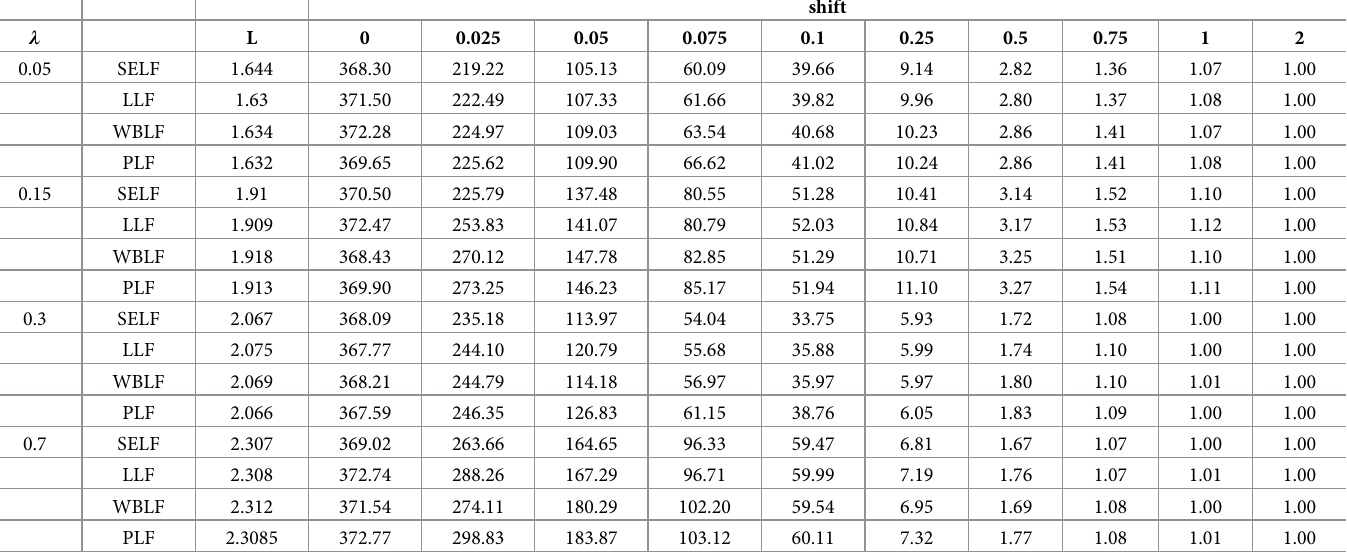
Table 2. ARL comparison for n = 10 under various loss function for ARL 0 = 370.